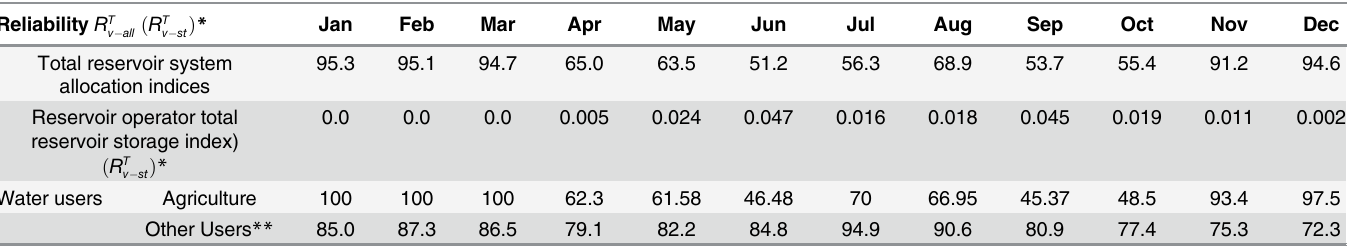
Table 4. Volumetric reliabilities of the reservoir system resulting from the simulation based on the presented method.